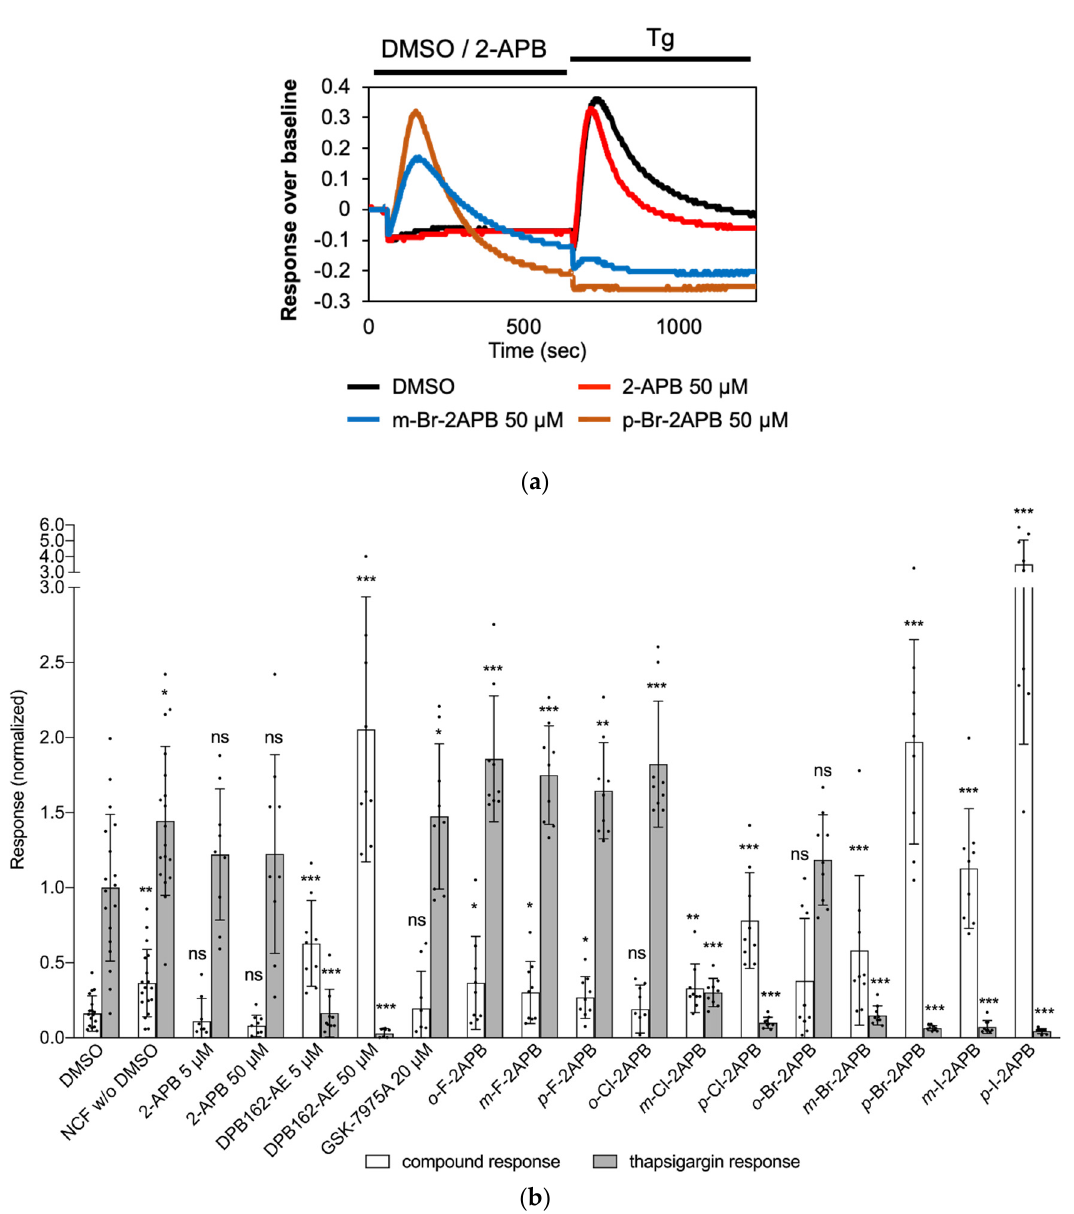
Figure 4. Store-depletion by selected 2-APB analogues in MDA-MB-231 cells. ( a ) Examples of recorded intracellular calcium responses for m -Br-2APB and p -Br-2APB in FLIPR assay. Black bars above traces indicate duration of compound applications. MDA-MB-231 cells were incubated with compounds (50 µM, unless otherwise noted) in NCF for 10 min, followed by thapsigargin (Tg, 2.5 µM) application in NCF buffer. ( b ) Quantifications of Ca 2+ mobilization effect from intracellular stores, using the slopes of the curves, by compounds (white bars) and by subsequent thapsigargin (dark bars) application. Normalized to post-thapsigargin response by DMSO, n ≥ 9 for all data points. Data shown are mean ± SD. Statistical significance is compared to the respective DMSO control and indicated as “***” for p ≤ 0.001, “**” for 0.001 < p ≤ 0.01 and “*” for 0.01 < p ≤ 0.05. ns, not significant for p > 0.05.